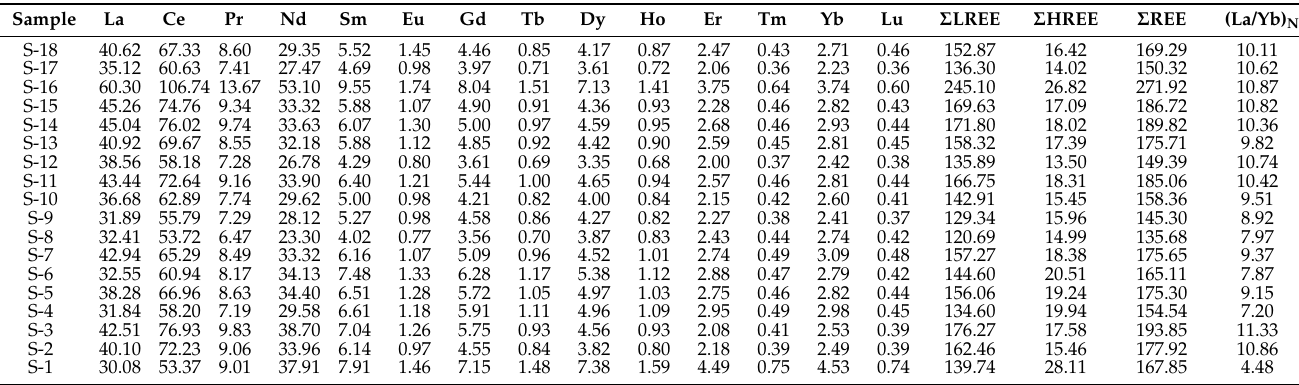
Table 2. Content of rare earth elements in Longmaxi-1 black shales